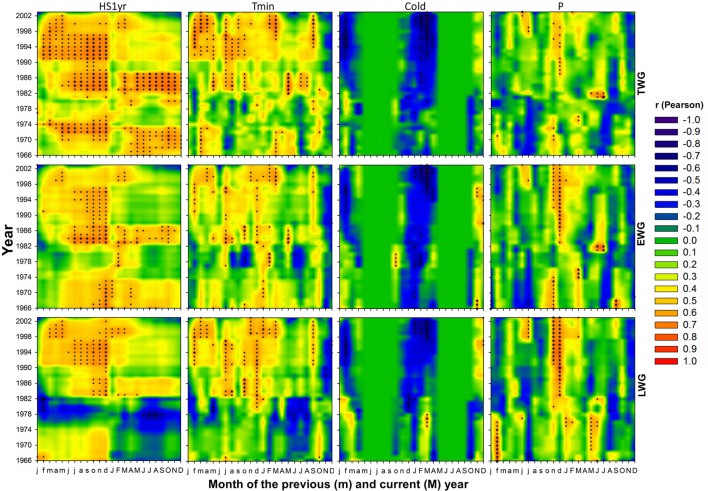
Contour plot representation of 15-year monthly moving correlations of annual (top), earlywood (middle), and latewood (bottom) ring radial growth versus climate variables: cumulated heat sum over 1 year (HS1y), minimum temperature (Tmin), number of cold days with Tmin < 5°C (Cold) and precipitation > 0.1 mm (P), respectively from left to right. Months of the current year are in upper case letters (M) while months of the year preceding the annual ring growth are in lower case letters (m). The stars are scaled according to the level of statistical significance of correlations (n = 15), with p < 0.05 for |r |≥ 0.515, p < 0.01 for |r |≥ 0.637 and p < 0.001 for |r |≥ 0.818, respectively.